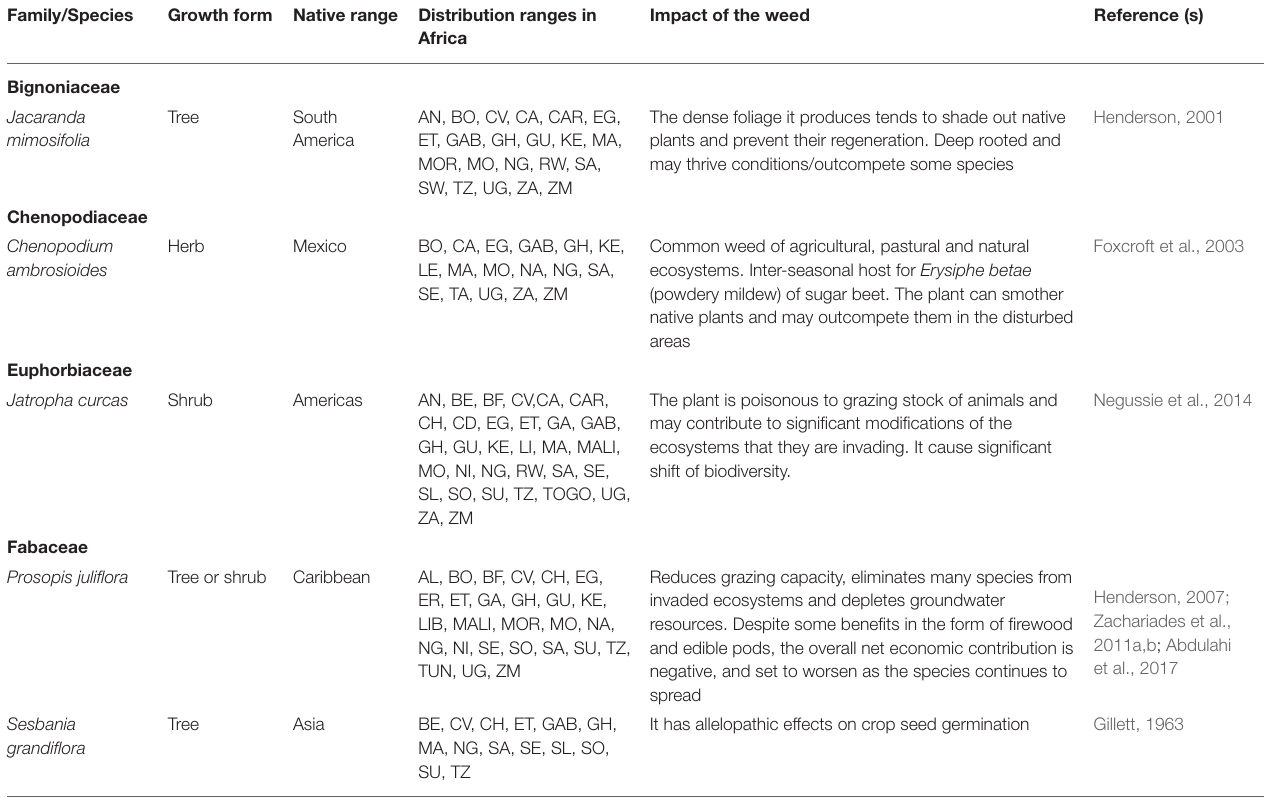
TABLE 1C | Published reports on the impact of some invasive alien plants in sub-Saharan Africa.